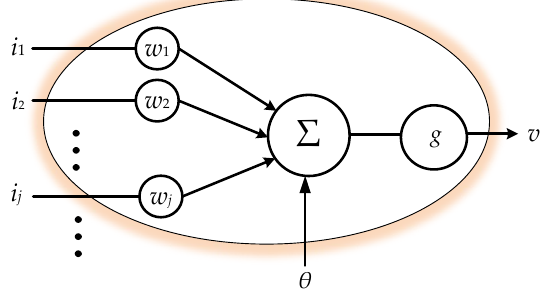
Figure 2. Model of a single neuron.